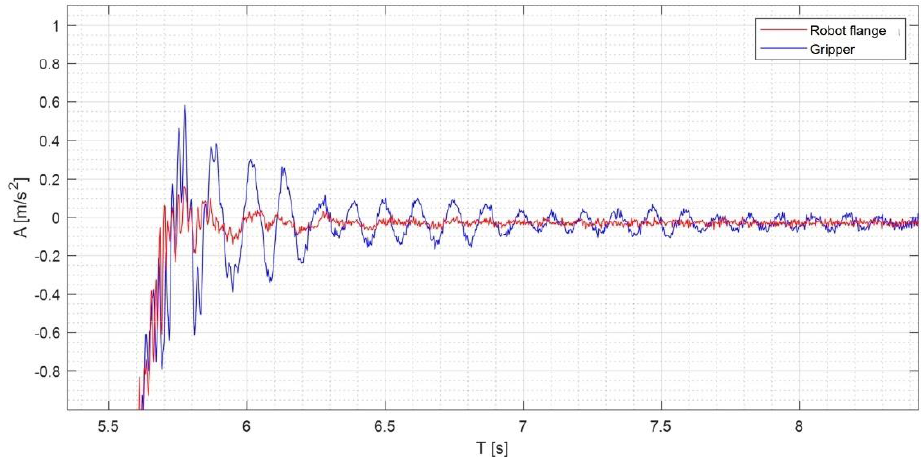
Figure 17. Acceleration graph area after robot stop for parameters V4000 and ACC100.